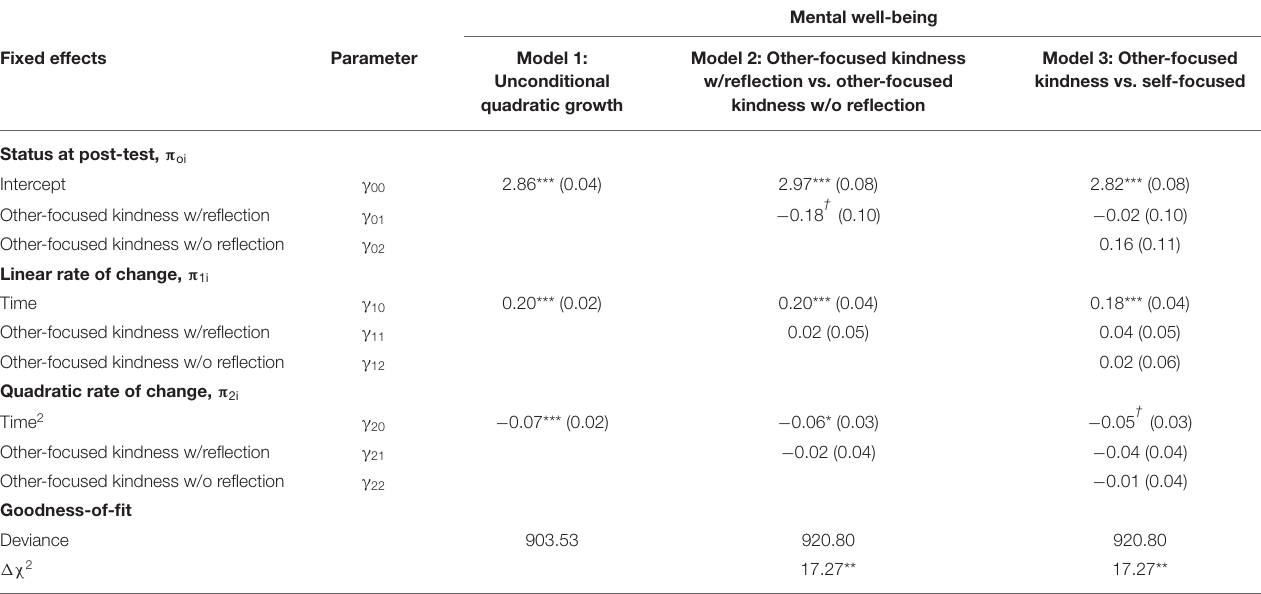
TABLE 4 | Parameter estimates and goodness of fit indices for multilevel growth curve models predicting changes in mental well-being up to 6-months follow-up comparing other-focused kindness with self-focused kindness.